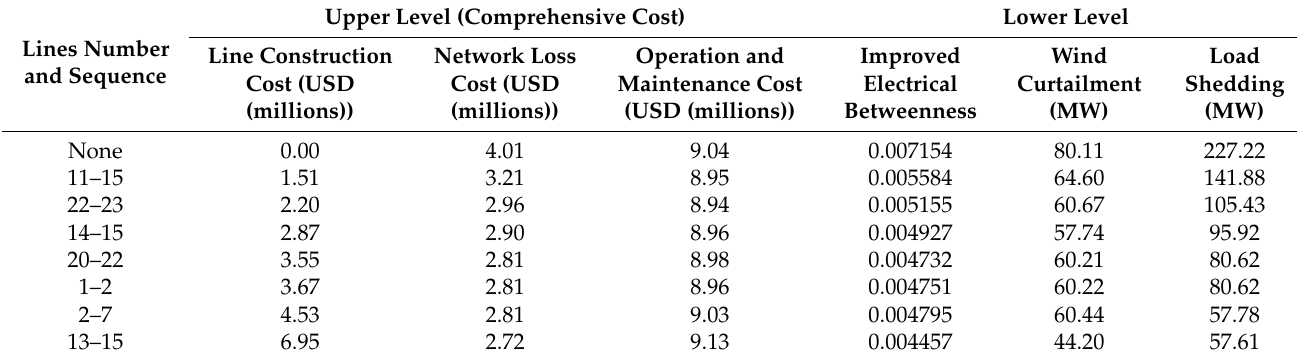
Table 5. TNEP scheme of multi-agent DDQN in modified IEEE RTS-24 bus system.